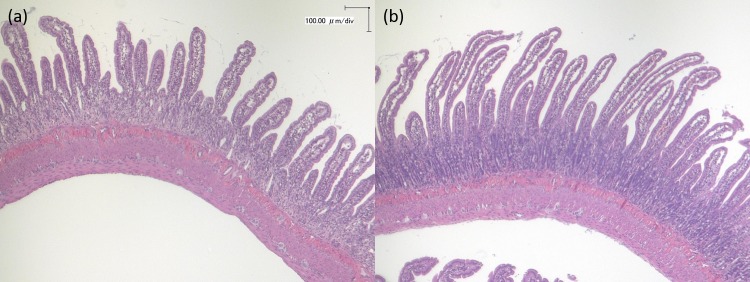
Microscopic features of the jejunum.(a) CTR group and (b) IMF group.